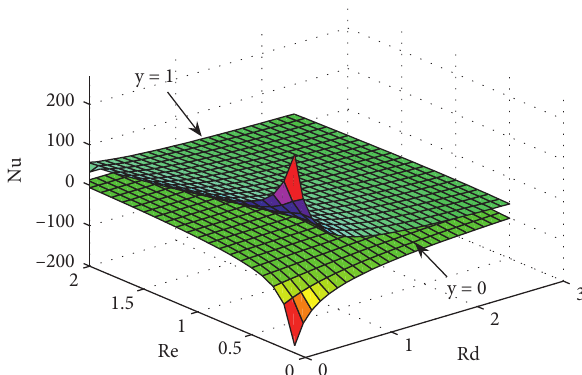
tRe–0.2–0.100.10.2 Figure 14: Effect of Re over time variation on the “unsteady Nusselt number distribution” for Ec � 1 , Rd � 2 , Ha � 0 . 5 , andPr � 21.